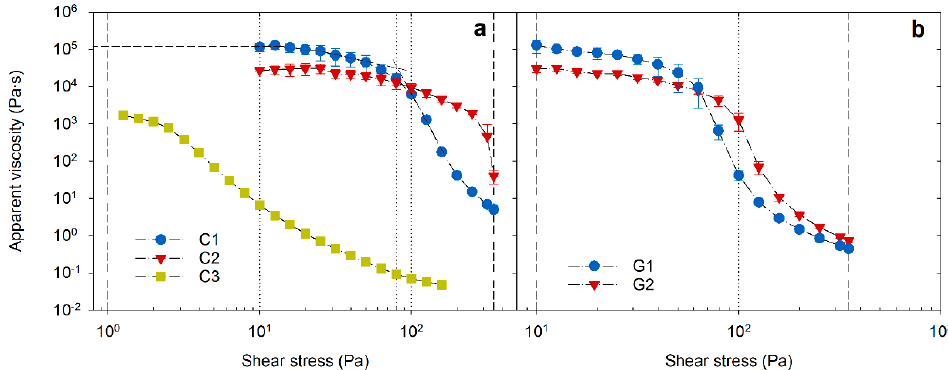
Figure 1. Viscosity flow sweep curves of cream ( a ) and gel ( b ) samples as a function of controlled shear stress. Reference lines from left to right are placed at 1, 10, 80, 100, and 350 Pa in ‘plot a’ and at 10, 100, and 350 Pa in ‘plot b’.